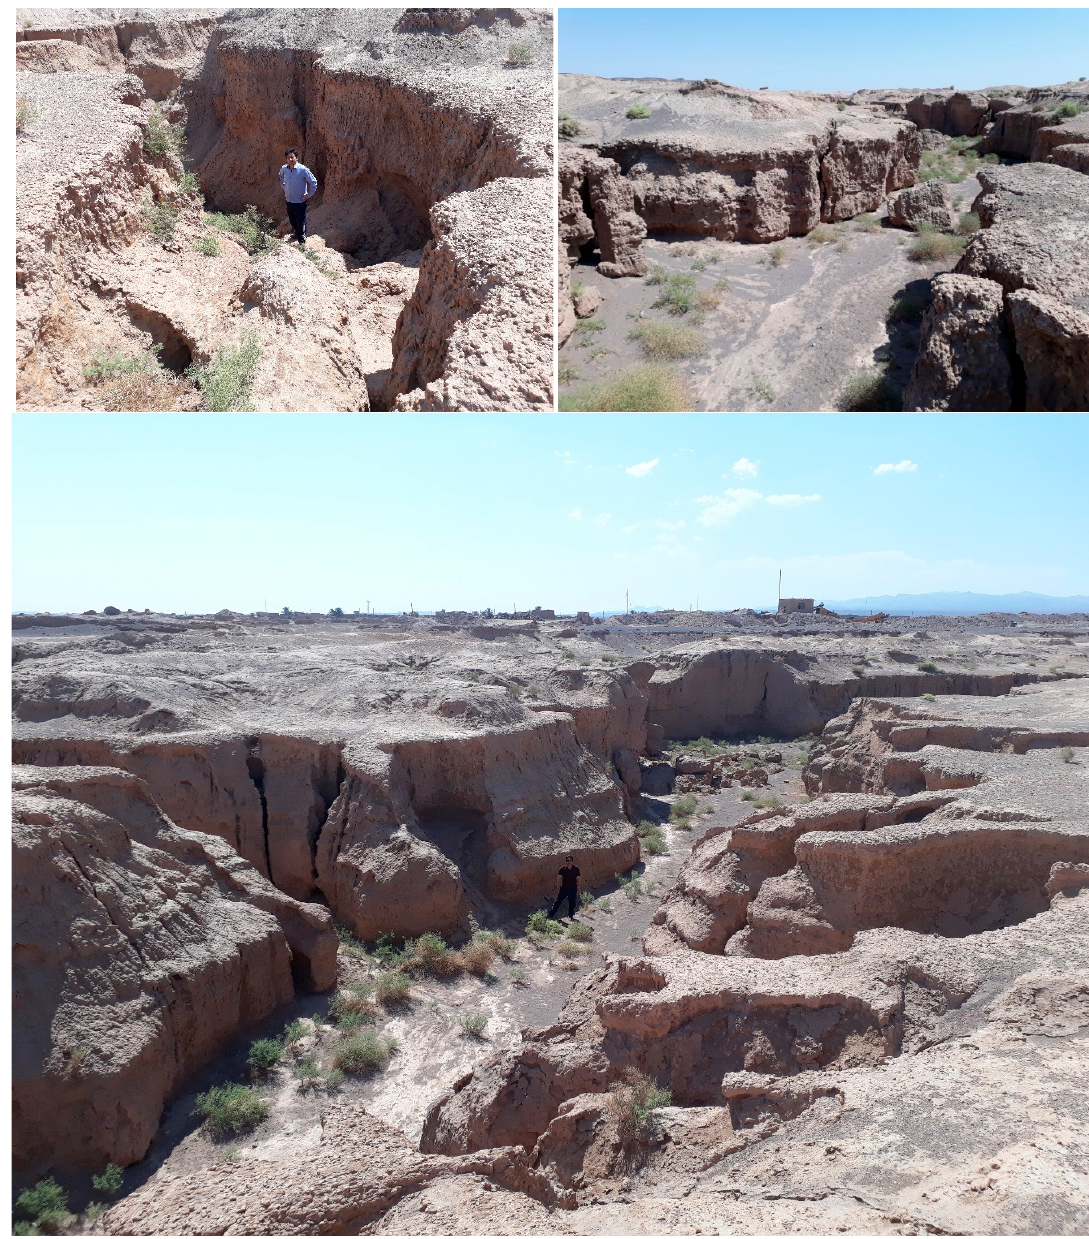
Figure 2. Sample of mapped gullies in the study area.